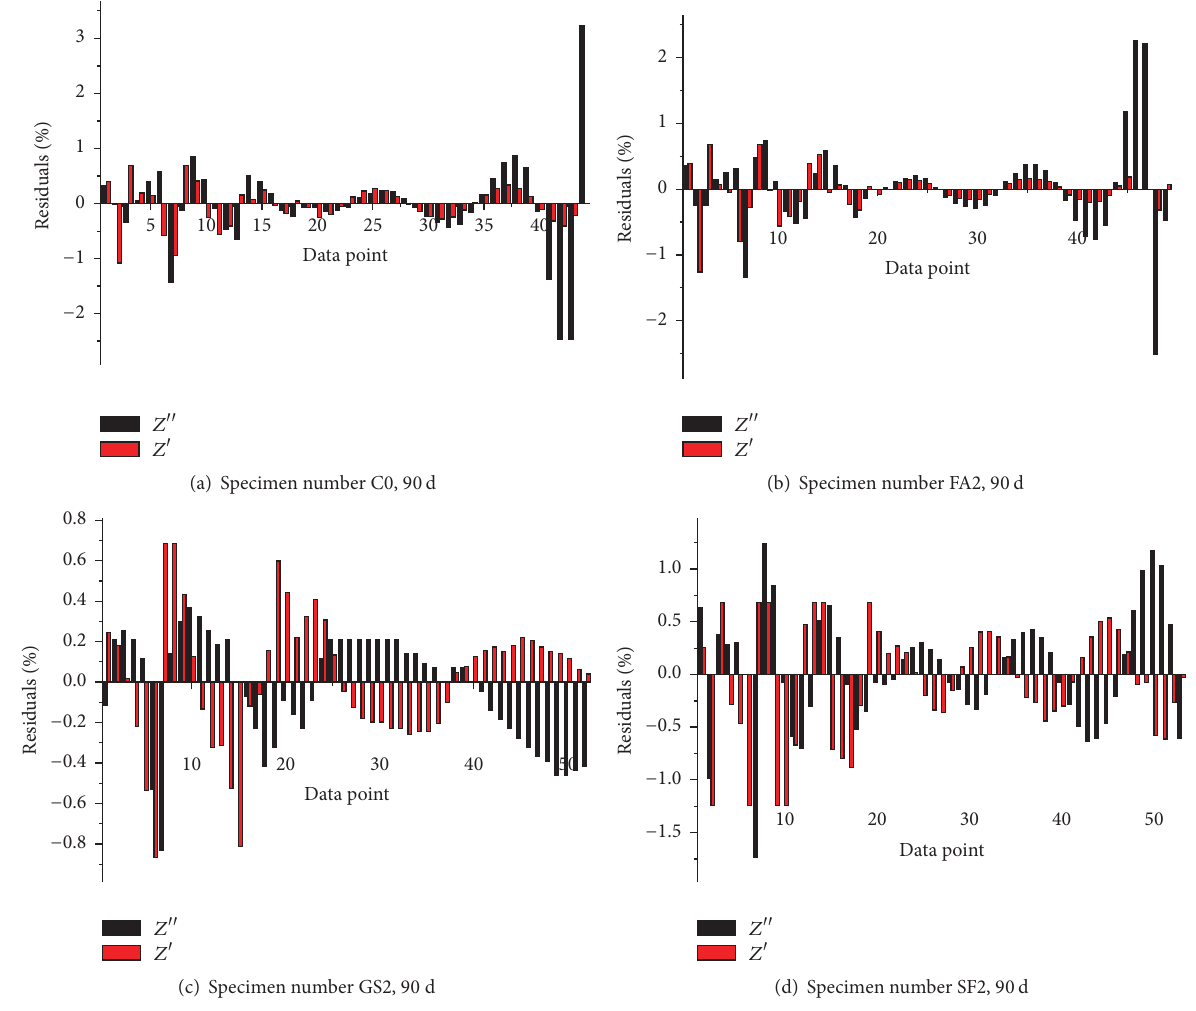
Figure 12: Validation